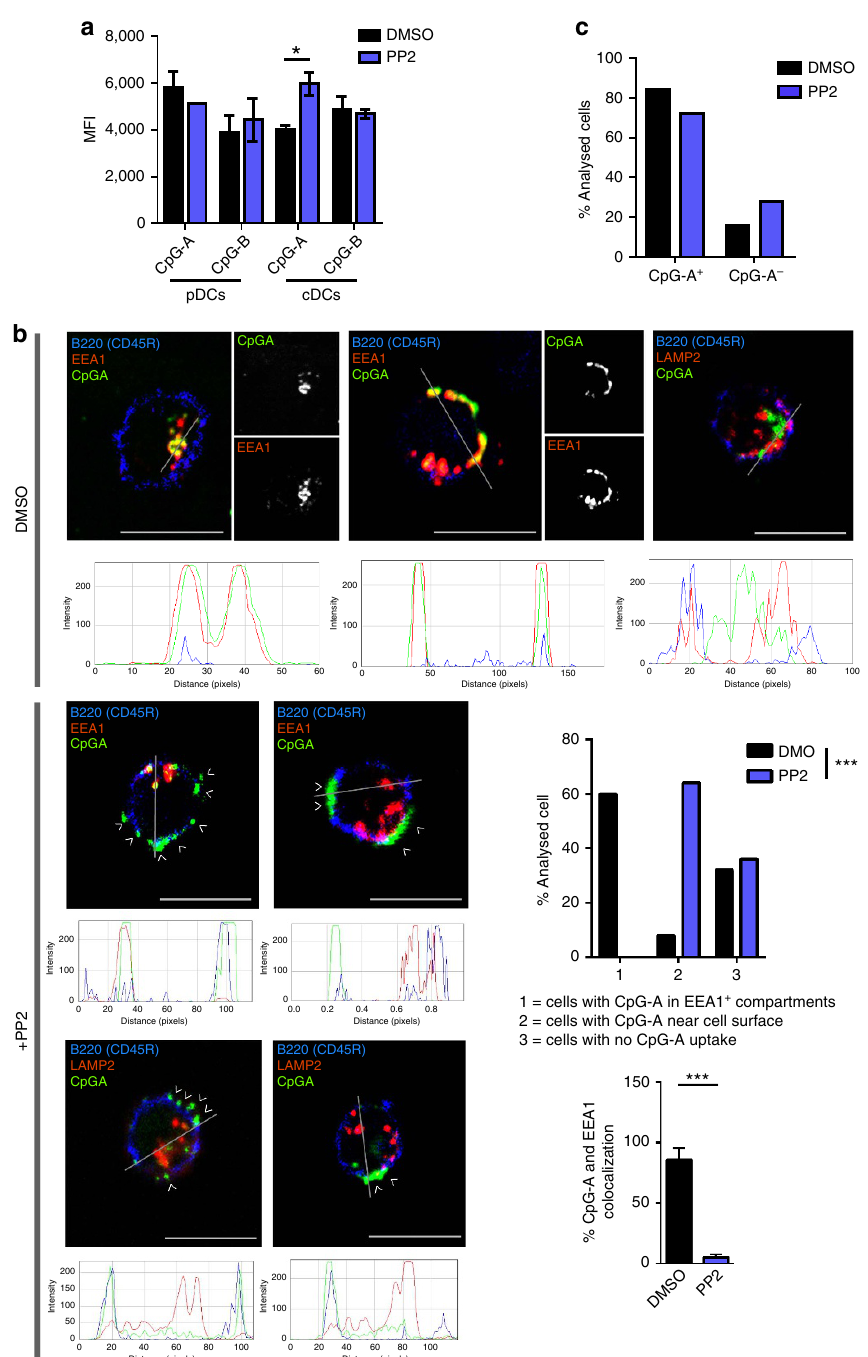
Figure 7 | SFK activity is necessary for TLR-ligand localization in early endosomes of pDCs. ( a ) BM-derived DCs cells were pre-treated for 1h with PP2 (10 m M; blue) or DMSO control (black) before stimulation with either CpG-A-FITC or CpG-B-FITC for 1h. CpG uptake was determined by flow cytometry in gated cDCs and pDCs. pDCs were gated as CD11c þ /CD11b (cid:2) /BST2 þ . Data are representative of three independent experiments. Graphs depict mean ± s.d. of replicates within one representative experiment. ( b , c ) BM-derived DCs were pre-treated for 1h with PP2 (10 m M; blue) or DMSO control (black), before stimulation with CpG-A-FITC for 90min. CpG-A-FITC internalization and colocalization with EEA1 or LAMP2 was evaluated by confocal microscopy in B220 þ ( b , pDCs) and B220 (cid:2) ( c , cDCs) cells. Examples of representative images are shown, with RGB plots underneath each panel. These plots quantify the degree of colocalization of CpG-A-FITC (green) with EEA1/LAMP2 (red) along the arbitrary line on each corresponding image, as measured using ImageJ. Bar graphs display the patterns of CpG-A-FITC localization/uptake and % colocalization with EEA1 determined in 50 cells analysed in two independent experiments ( b ). CpG uptake in cDCs is graphed as percentage of positive cells within 50 cells analysed in two independent experiments ( c ). Two-ways Student’s t -test ( a , b ) and w 2 -test ( b , c ) were used for statistical analyses. Scale bars, 10 m m. * P o 0.05, ** P o 0.01, *** P o